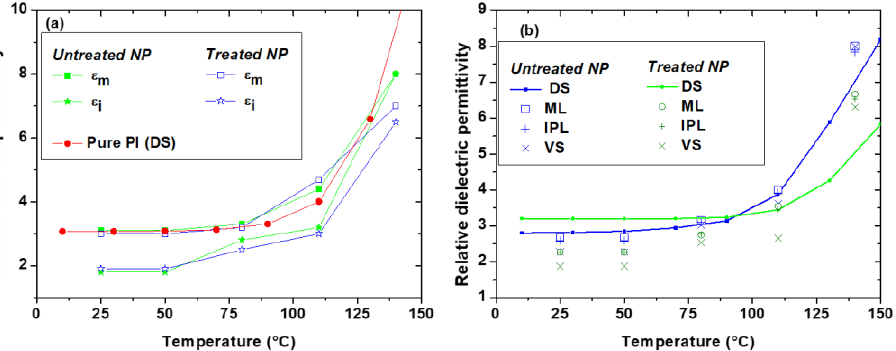
Figure 6. ( a ) Evolution of the relative dielectric permittivity of the matrix ( ε m ) and interphase ( ε i ) as function of temperature. Comparison is done with pure PI permittivity obtained by DS (0.1 Hz). ( b ) Comparison of the evolution of the experimental (DS at 0.1 Hz on untreated and treated NPs) and the computed apparent relative dielectric permittivity, with various models, as a function of temperature. Table 2. The matrix ( f m ), NPs ( f NP ), and interphase ( f i ) volume fractions as well as the interaction parameter K for untreated and treated nanocomposites.